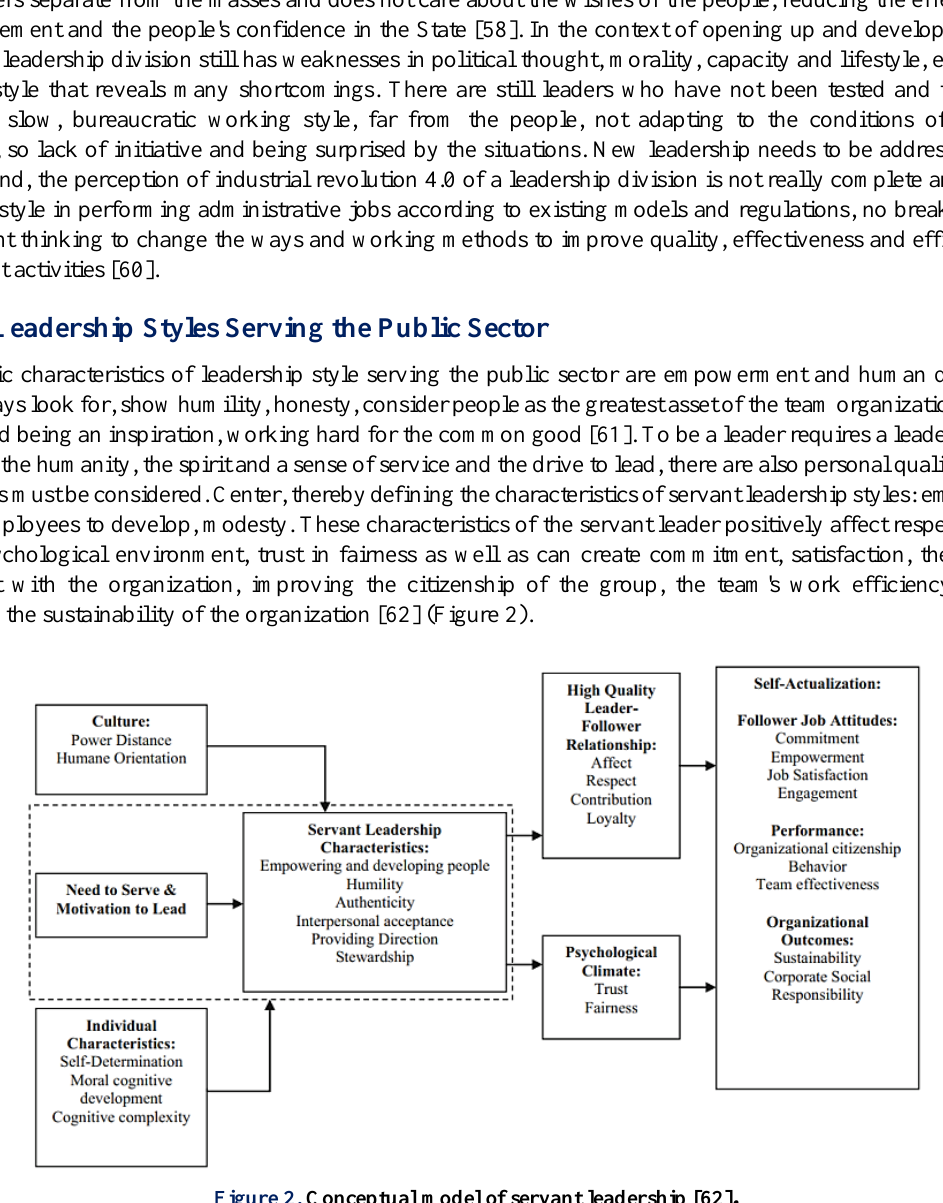
Figure 2. Conceptual model of servant leadership [62]